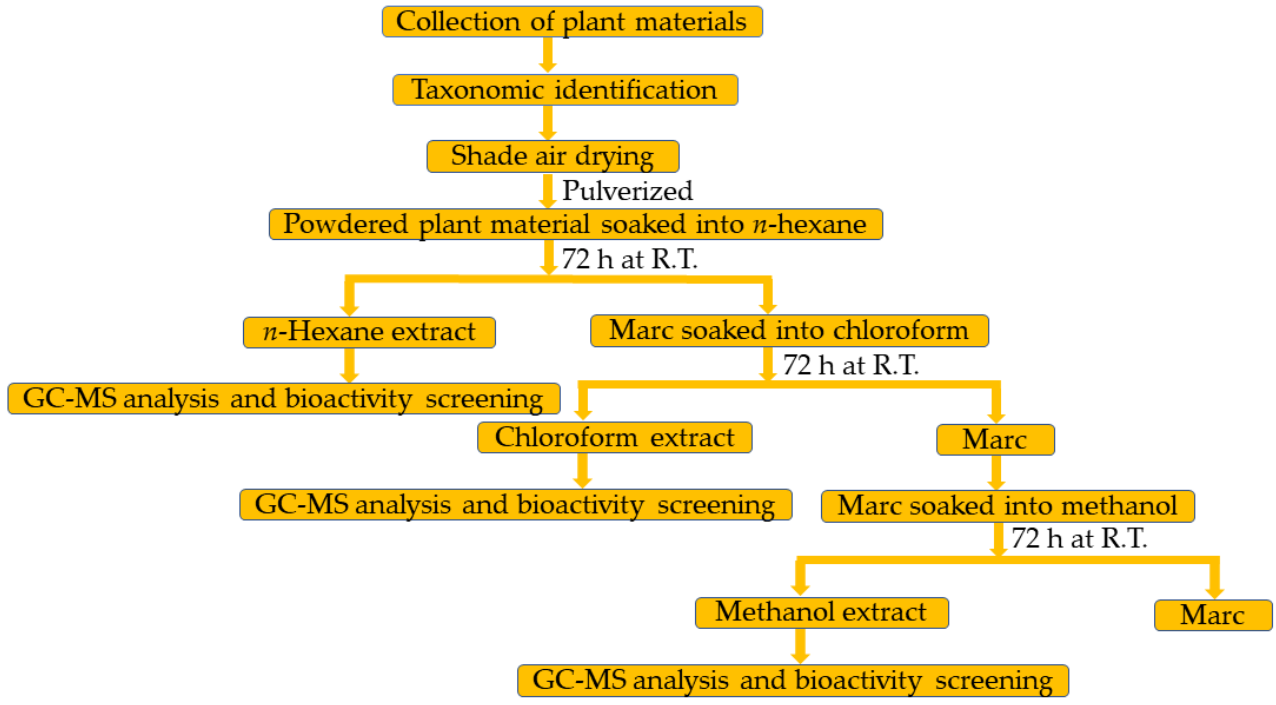
Figure 1. Flowchart for the preparation of C. colocynthis seeds extracts and their bioactivity screening. The extraction was carried out individually by using an initial 500 g of seeds of C. colocynthis in each solvent, which yielded 11.2 g, 50.0 g, and 70.0 g of seed extract in M.E., H.E., and C.E., respectively. Notably, the extraction processes have yielded an almost similar color (dark brown) of extracts in all the solvents; however, their amount was